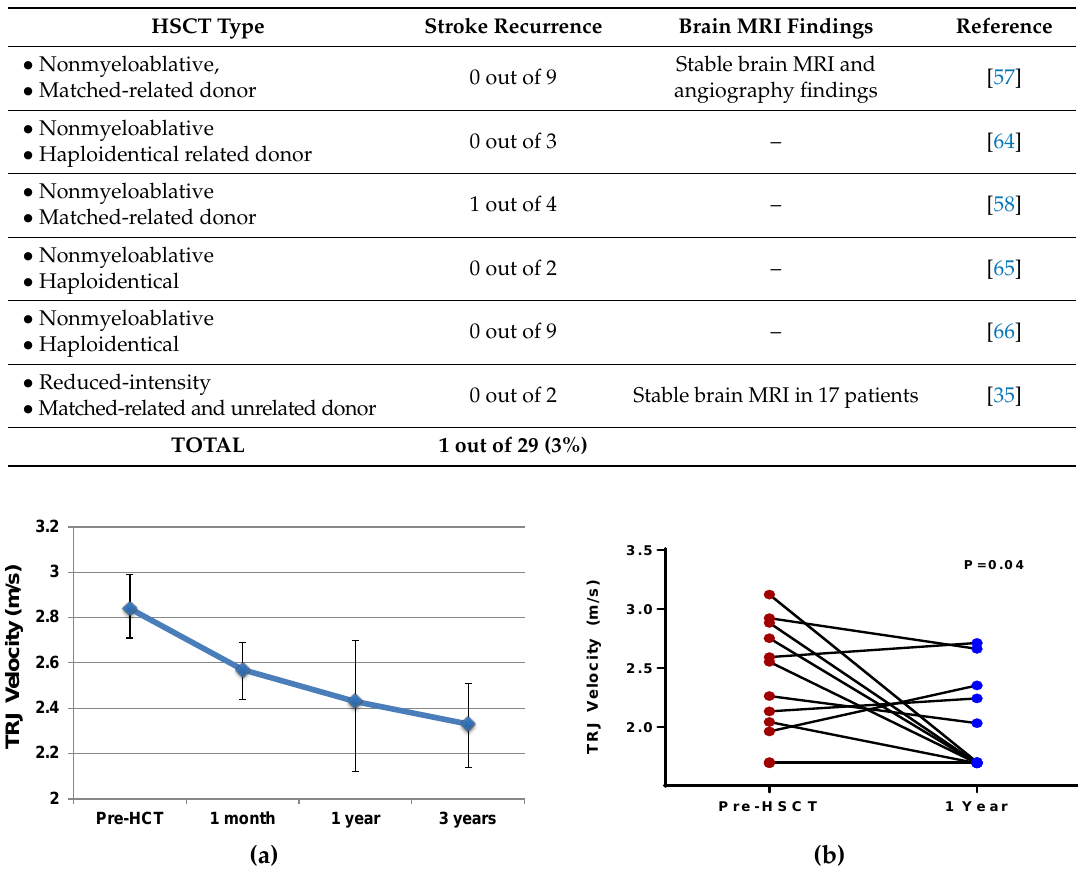
Figure 1. Improvements in the tricuspid regurgitant jet velocity (TRJV) after hematopoietic stem cell transplantation in adults with sickle cell disease from ( A ) the National Institutes of Health ( n = 13) and ( B ) University of Illinois at Chicago (pre-HSCT mean = 2.3 ± 0.5 m/s, post-HSCT mean = 2.0 ± 0.4 m/s) ( n = 12) cohorts, using an alemtuzumab and total body irradiation conditioning regimen.